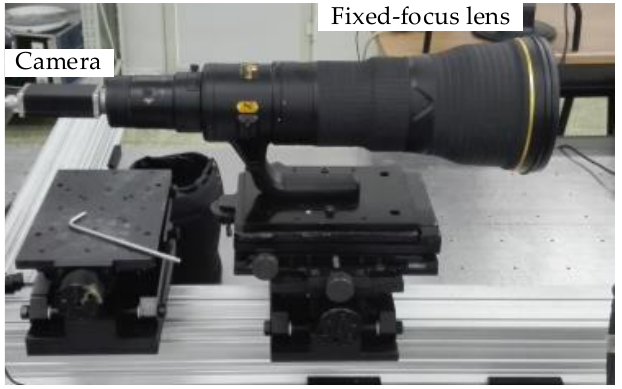
Figure 1. Photo of the imaging system.